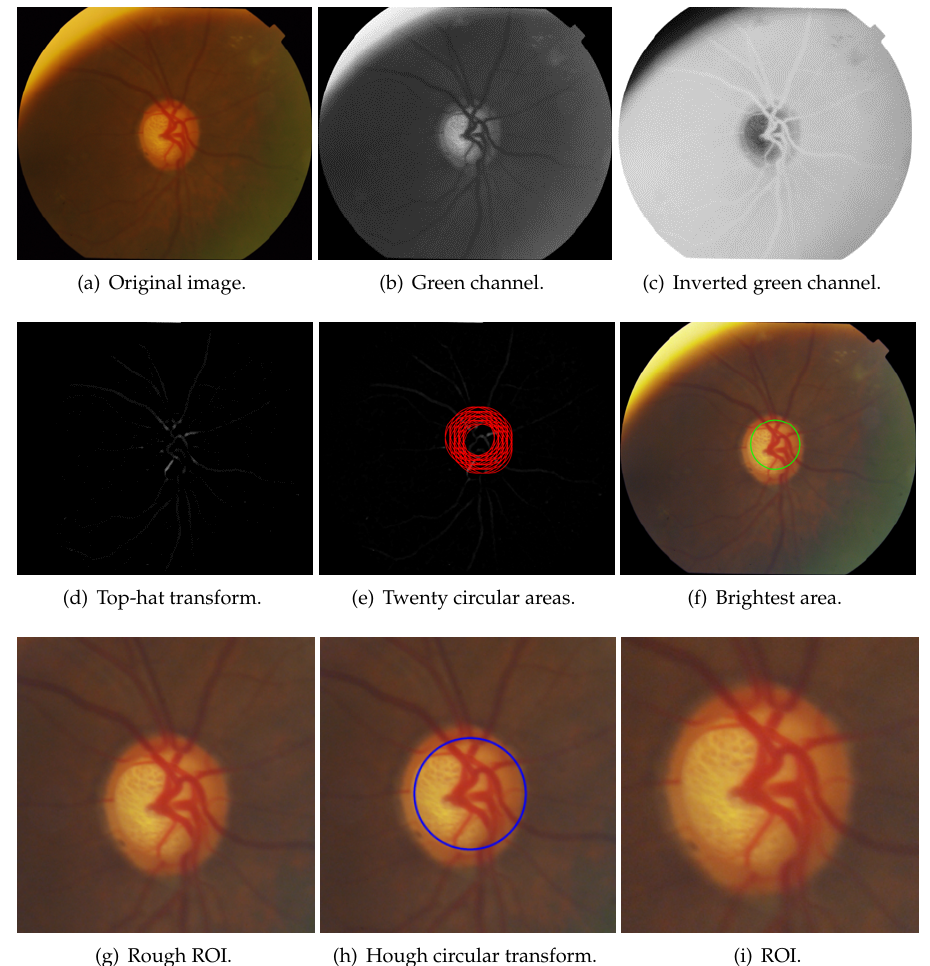
Figure 9. Results of ROI detection in posterior fundus images.